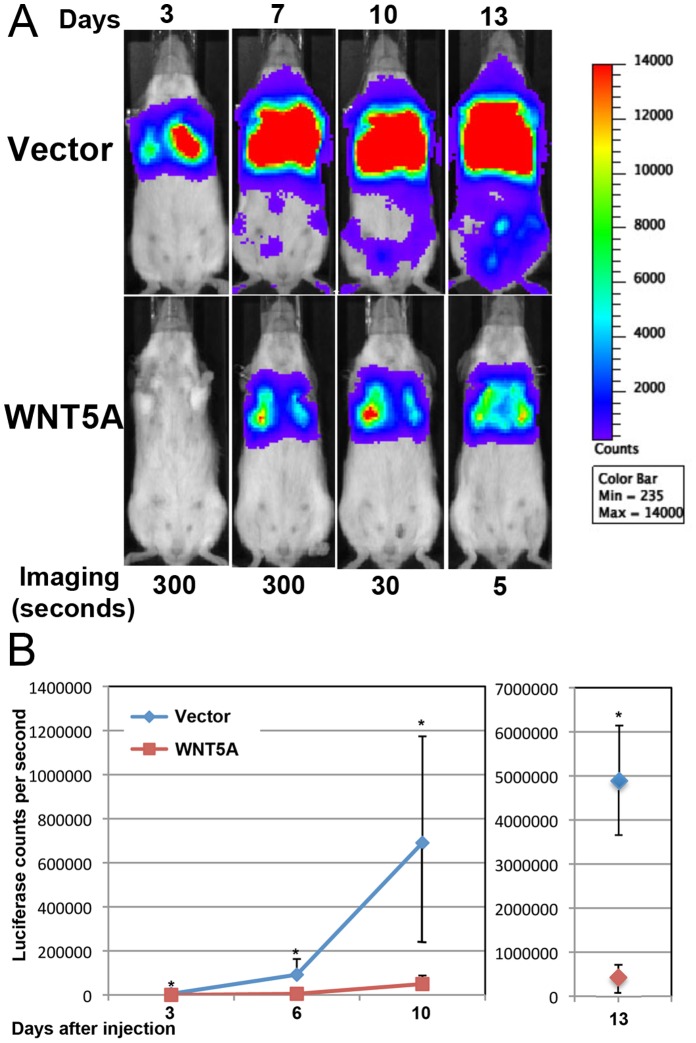
WNT5A inhibits metastasis to the lung.The tail vein assay was used to compare metastasis to the lung of vector only transduced 4T1-luc (Vector) and WNT5A expressing 4T1-luc (WNT5A) cells. (A) Luciferase imaging over several days after injection is shown. Red represents the highest intensity of luciferase signal. The imaging time in seconds is shown at the bottom. (B) The average and standard deviation from 6 mice in each group of luciferase counts per second is shown over time. Luciferase counts were significantly reduced in 4T1-Luc-WNT5A cells starting at 3 days after injection (*T-test p-value <0.05). Note Day 13 results are shown on a different scale.